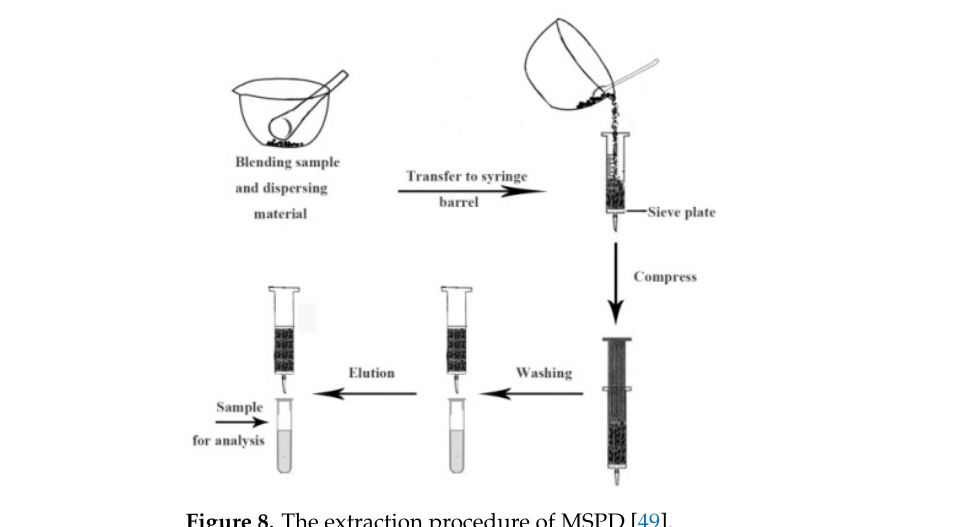
Figure 8. The extraction procedure of MSPD [49].